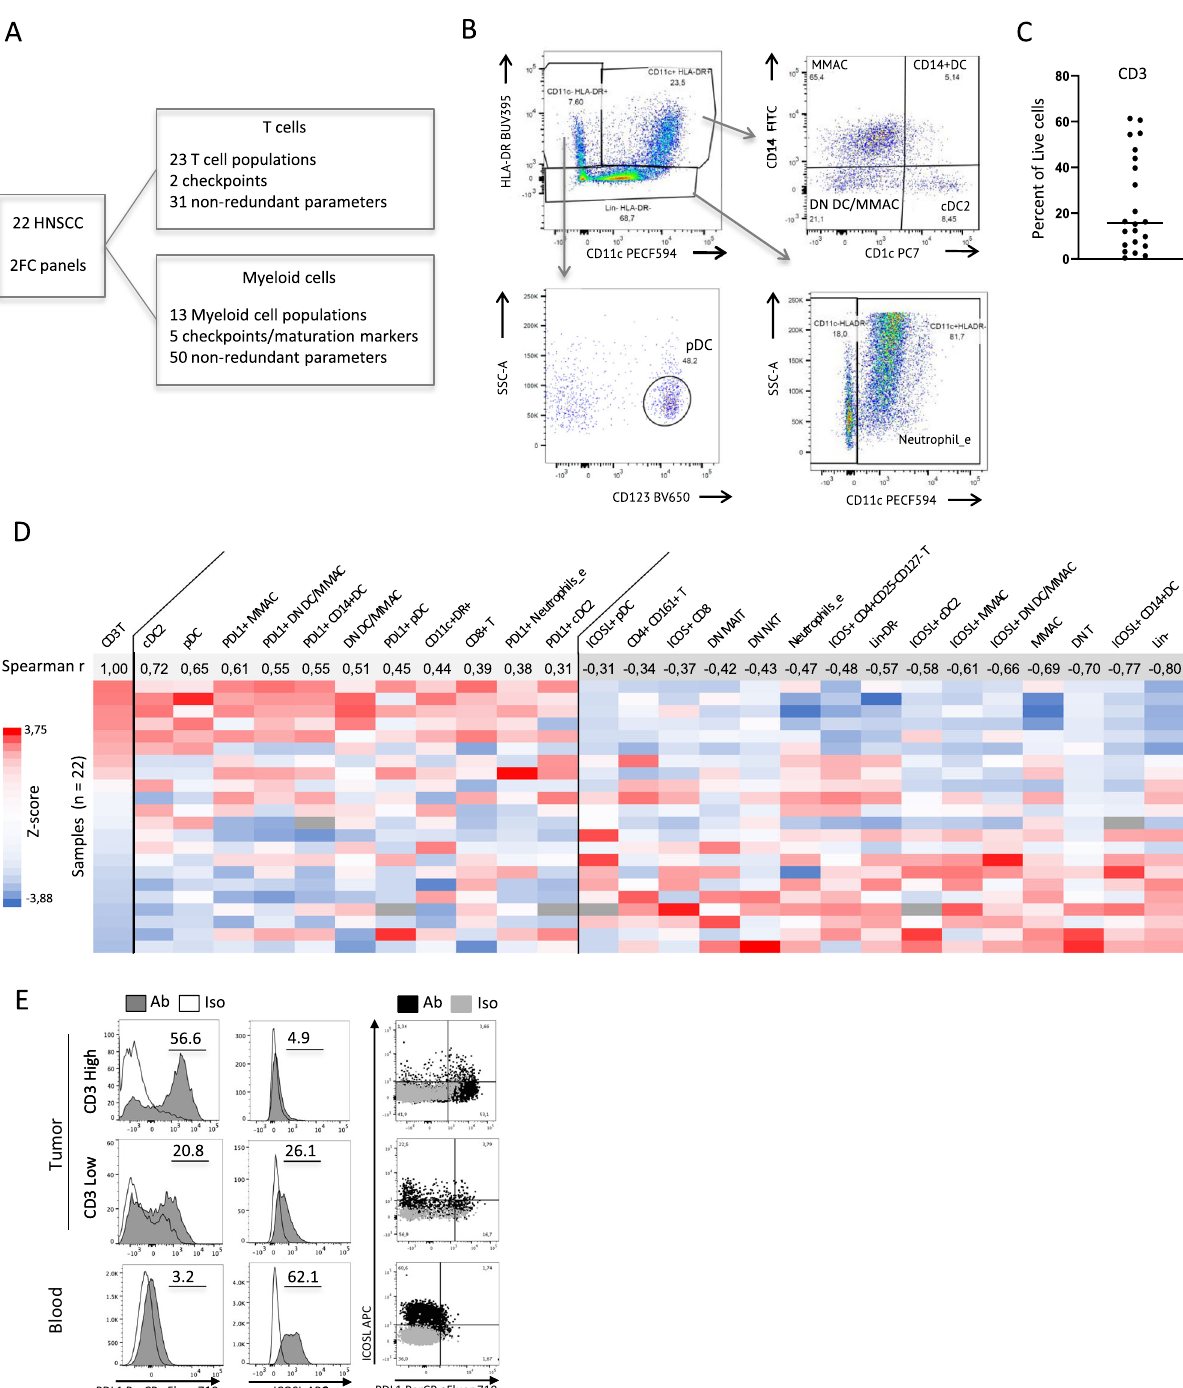
Fig. 1 T-cell-in fl amed head and neck squamous cell carcinoma are enriched in cDC expressing PD-L1 high and ICOSL low/neg . Phenotypic characterization of 22 human head and neck squamous cell carcinoma (HNSCC) primary tumor-in fi ltrating cells. A Multicolor fl ow cytometry (FC) analysis scheme. B Myeloid cell panel gating strategy for the CD45 + CD3 − CD16 − CD19 − (Lin) compartment (initial gates in Supplementary Fig. 2A). MMAC monocytes and macrophages, DN DC/MMAC double negative population. C Percentage of CD3-positive cells among live cells, bar represents median. D Heatmap representing the normalized values of the parameters (columns) with a Spearman correlation coef fi cient (r) over 0.3 (left) or under − 0.3 (right) for the 22 tumors (rows) ordered from top to bottom by decreasing CD3/Live normalized value. Dark gray cells represent missing values. T T cells, pDC plasmacytoid DC, DR HLA-DR, Neutrophils_e neutrophils enriched, DN MAIT, NKT, T CD4 − CD8 − MAIT, Natural Killer T, and T cells, respectively. E Representative staining of PD-L1 (left), ICOSL (center), and PD-L1 versus ICOSL (right) in CD11c + DR + cells in a CD3 high tumor (top), CD3 low tumor (middle) from the cohort in D , and blood from a healthy donor (bottom); the percentage of positive cells was measured based on antibody (Ab) as compared to isotype